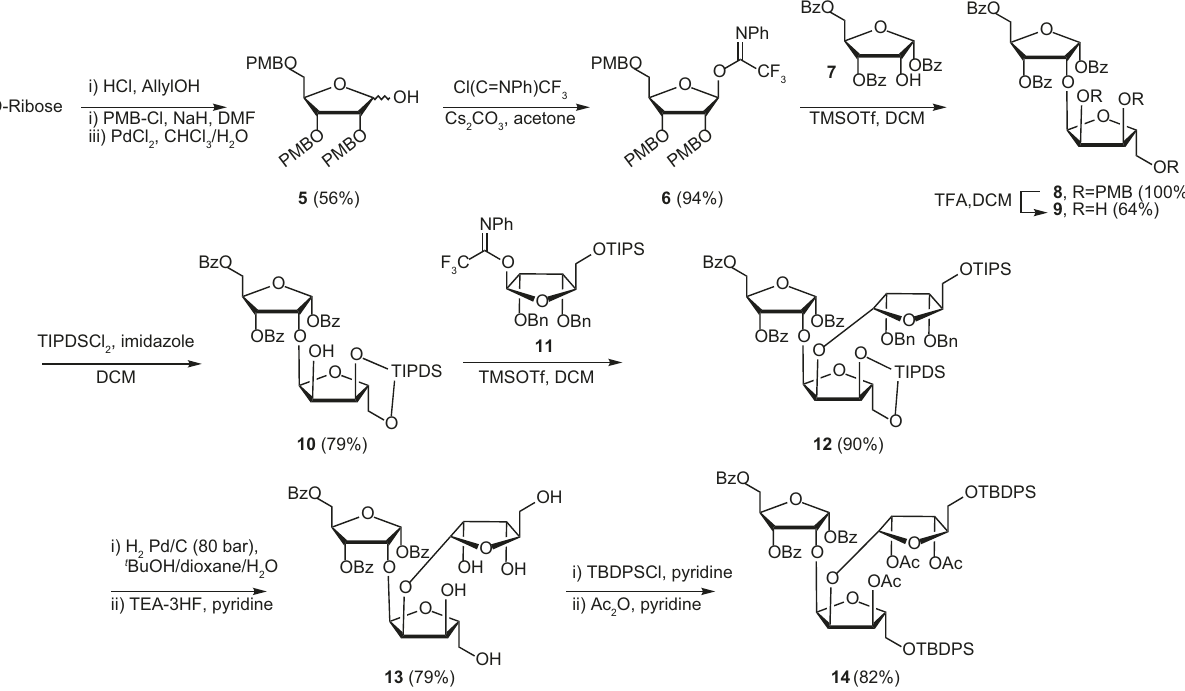
Fig. 2 Synthesis of protected parotriose (14). D -Ribose is the starting material for the synthesis of donor 6 which is further coupled with acceptor 7 and donor 11 to obtain parotriose derivative 14 . Yield after each step is given as percentage in brackets. PMB para -methoxylbenzyl, TMSOTf trimethylsilyl tri fl uoromethanesulfonate, DCM dichloromethane, TIPDS 1,1,3,3-tetraisopropyldisiloxane, TIPS triisopropylsilyl, Bn benzyl, TEA-HF Triethylamine trihydro fl uoride, TBDPS tert